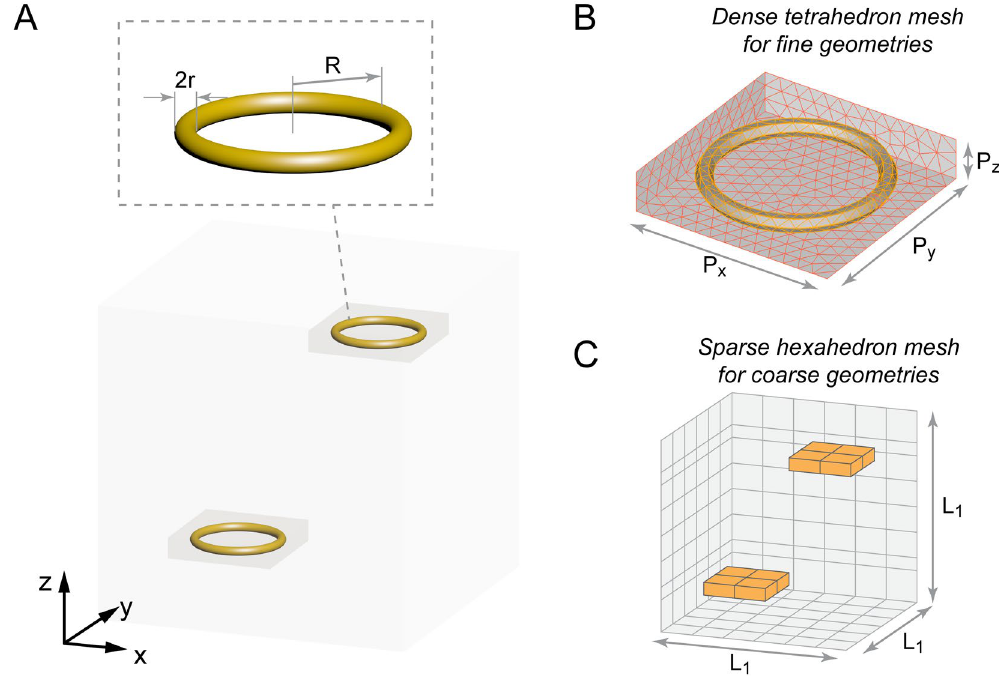
Figure 1. Geometry and mesh of the nanoloop coupling example. ( A ) The centers of the two gold nanoloops are located at [ − 500, − 500, − 900] nm and [500, 500, 900] nm, respectively. The radius R is 400 nm and the thickness, 2 r , is 80 nm. ( B ) The nanoloops and their surrounding spaces are separated from the entire computational region and meshed with low-order tetrahedrons to capture the detailed geometry information. (Only the mesh on the surfaces are shown while the volumetric mesh is hidden to improve visual clarity. Three of the exterior surfaces are set to be transparent to reveal the nanoloop). P x = 1000 nm; P y = 1000 nm and P z = 200 nm. ( C ) The remaining of the physical region is meshed with high-order hexahedrons. The space inside the yellow boxes are vacuum as they have already been meshed with tetrahedrons in ( B ). L 1 = 3000 nm. The shared interfaces (yellow surfaces) uses rectangles mesh on one side while the other side uses triangles. Ren et al . have introduced the technique, which is also used in this work, to solve the energy communication across these non-conformal interfaces 32